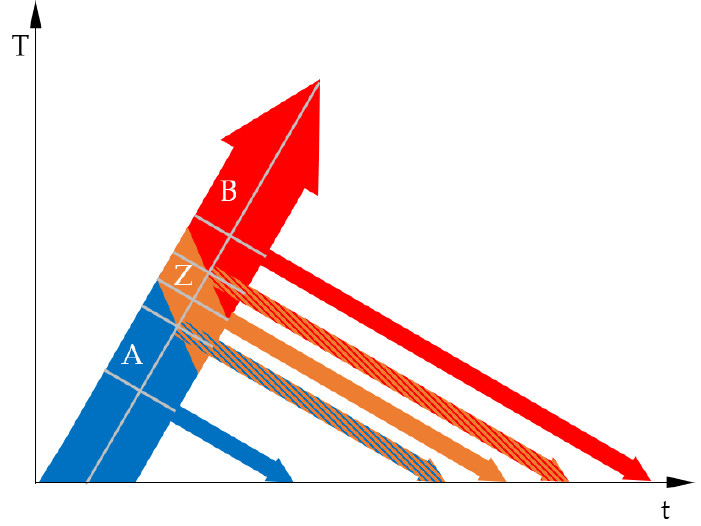
Figure 7. Schematic of the implemented phase transformation during heat treatment.